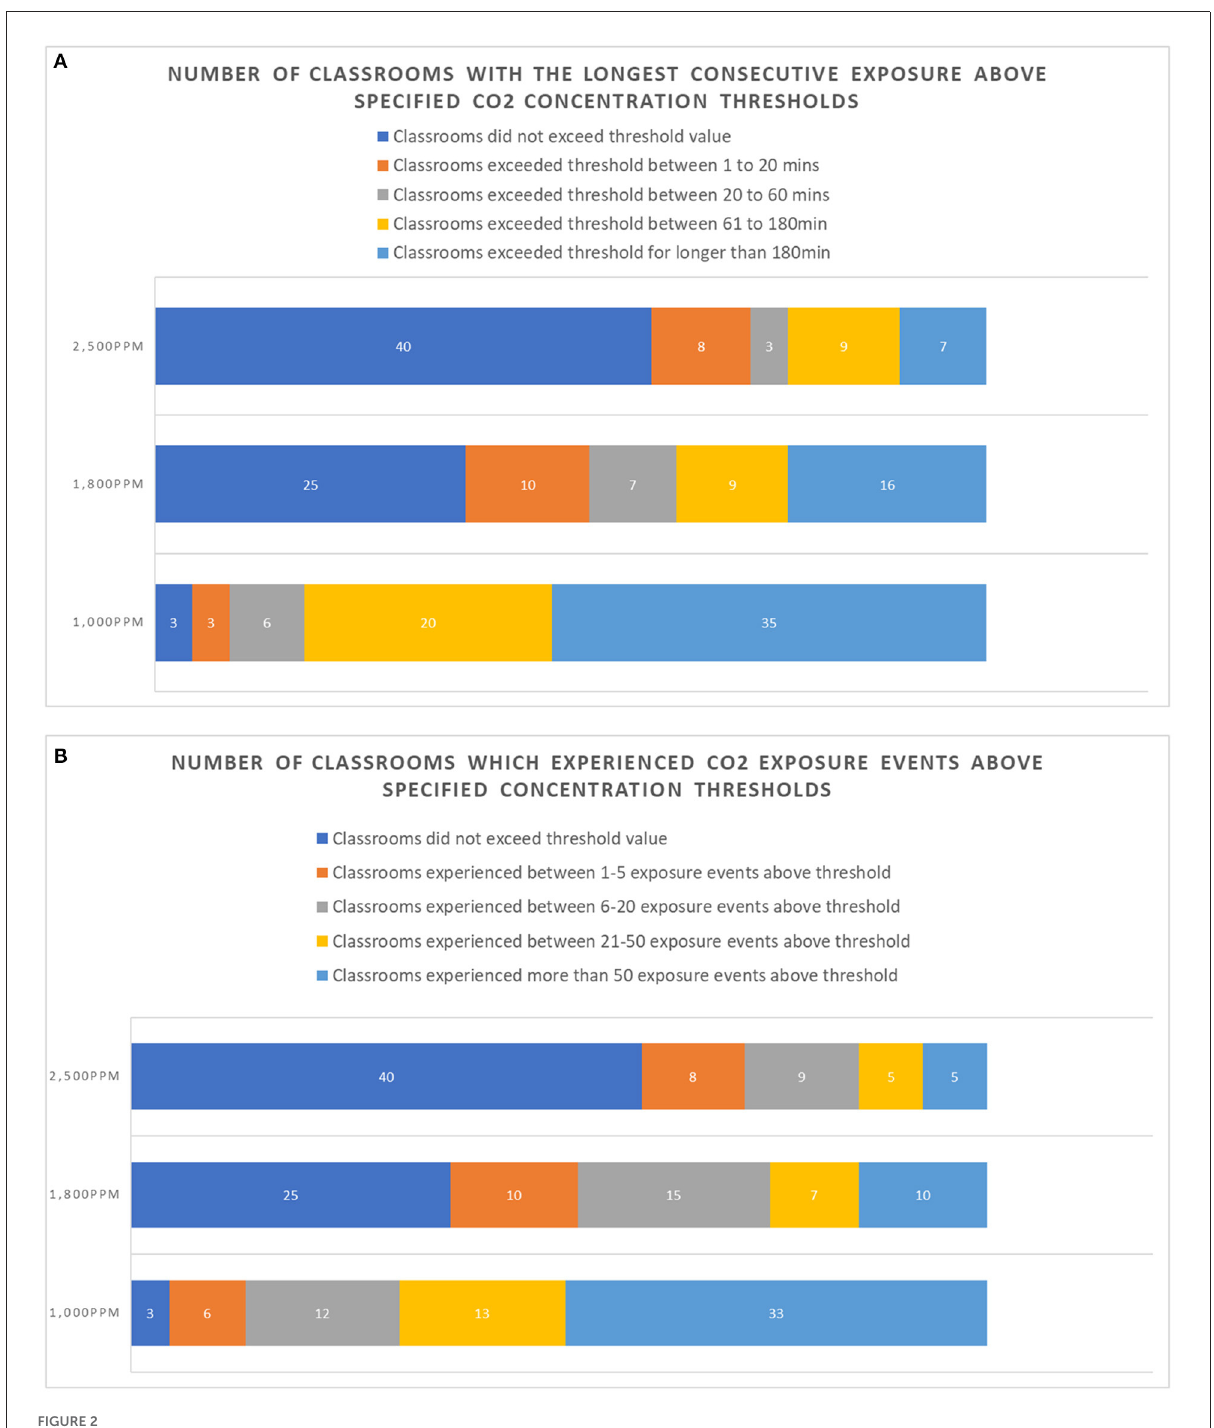
FIGURE2 (A) Duration of longest continuous CO 2 exceedance above each threshold value; number of classrooms. (B) Number of separate exceedance events of each threshold tested (number of classrooms).